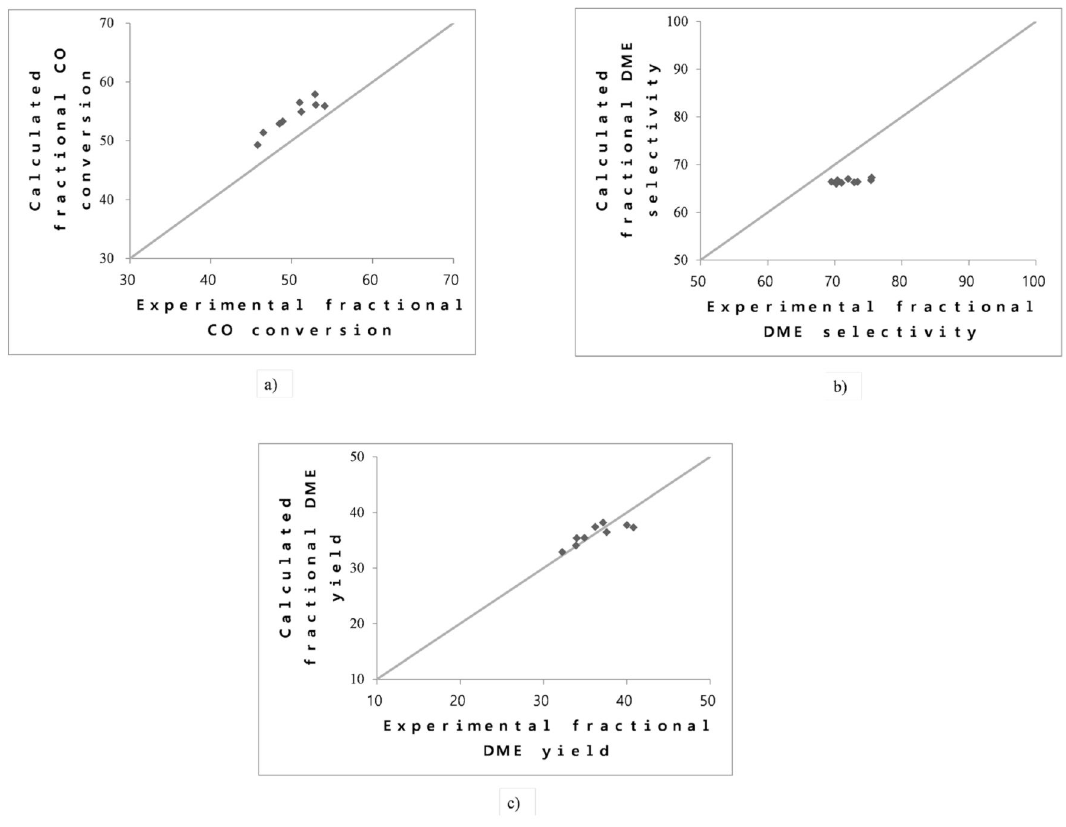
Figure 4. Parity plots for fractional ( a ) CO conversion, ( b ) DME selectivity, and ( c ) DME yield.